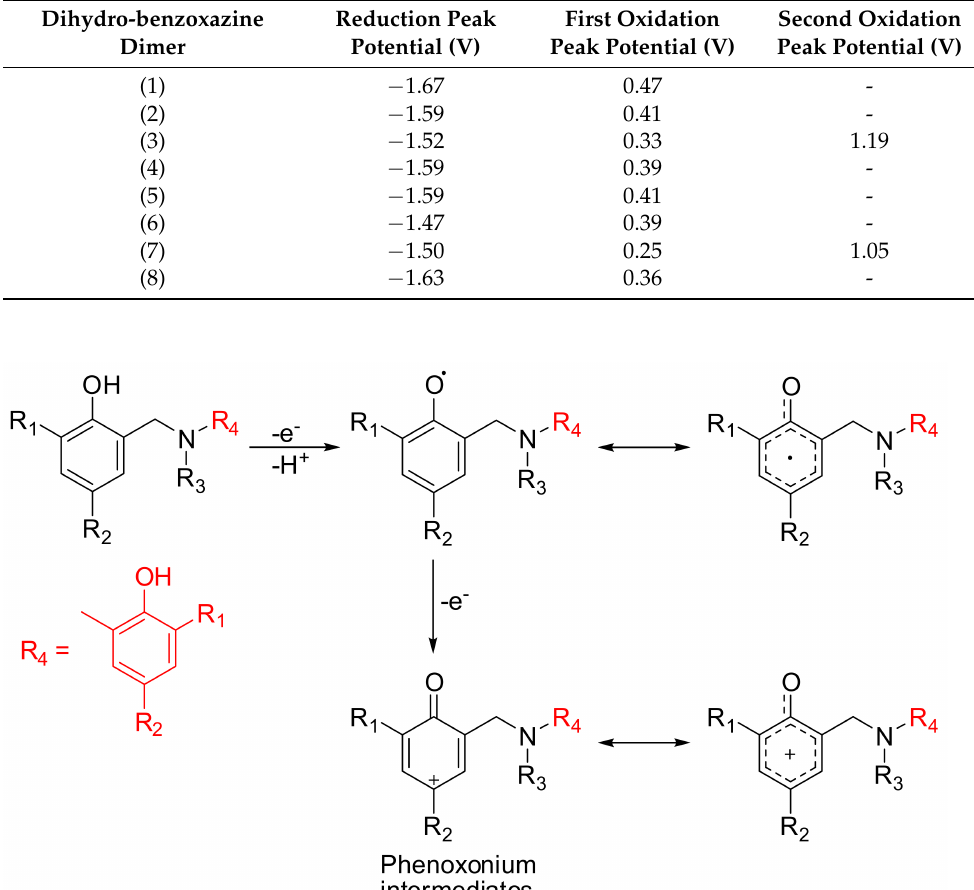
Figure 6. Cyclic voltammograms of ( a ) the dihydro-benzoxazine dimer (5) and ( b ) the dihydro-benzoxazine dimer (7) in ACN containing TBAPF 6 as an electrolyte at the scan rate of 100 mV s − 1 . Table 6. List of the reduction and the oxidation peak potentials of the dihydro-benzoxazine dimers derived from cyclic voltammetry.